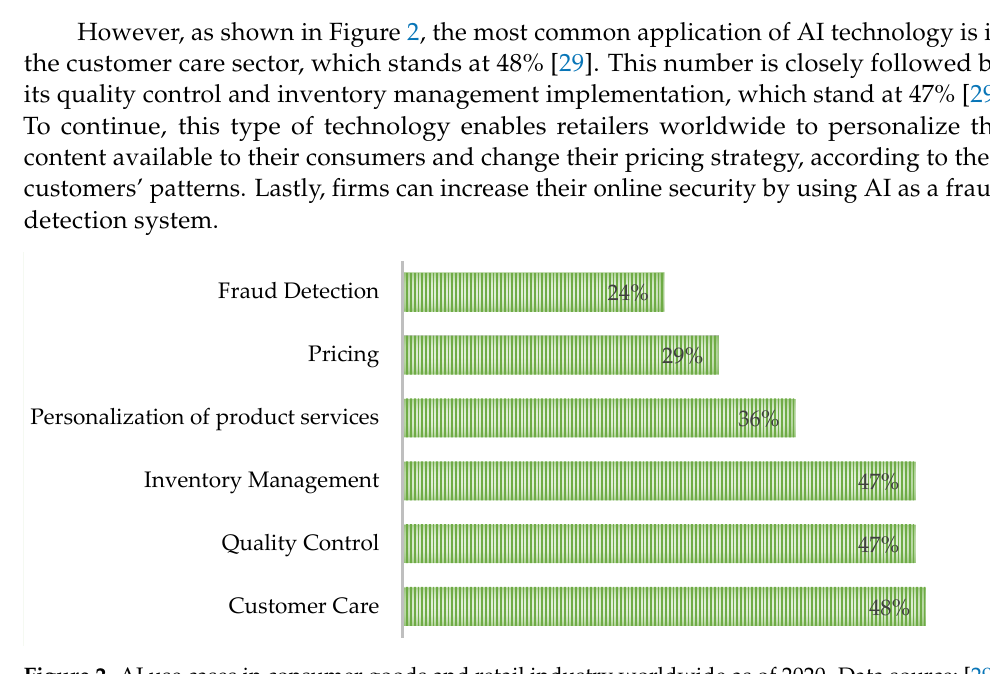
Figure 1. Future areas in which AI will help e-commerce businesses, according to decision makers in North America and Europe in 2021. Data source: [28].